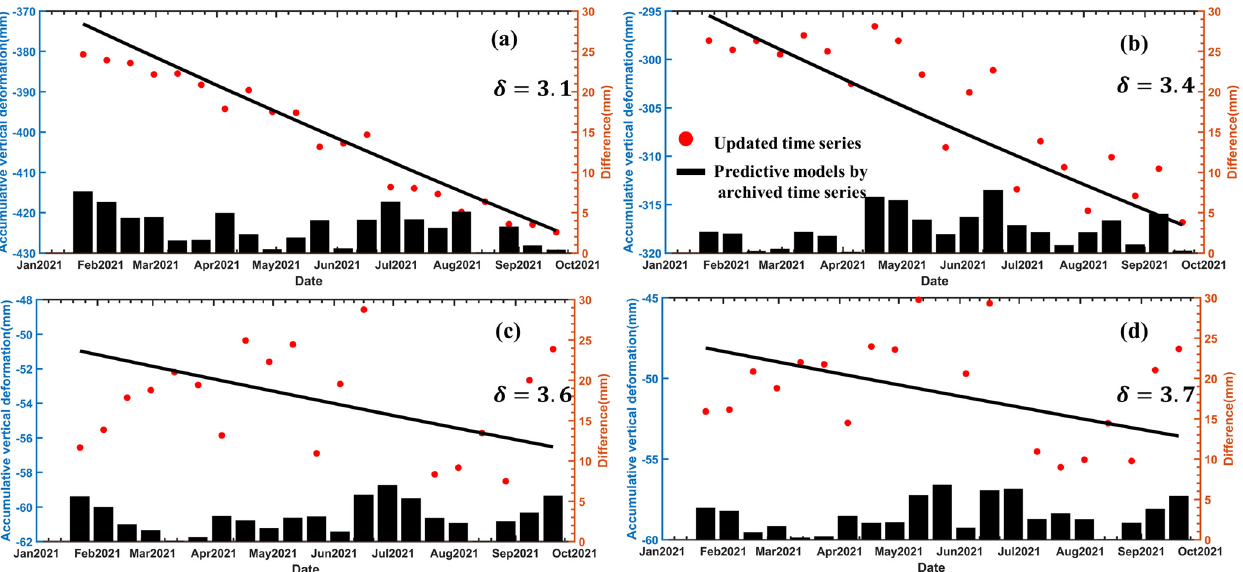
Figure 10. The difference between the prediction by archived deformation time sereis and the estimation by the sequential method at four points S1 to S4 ( a – d ).